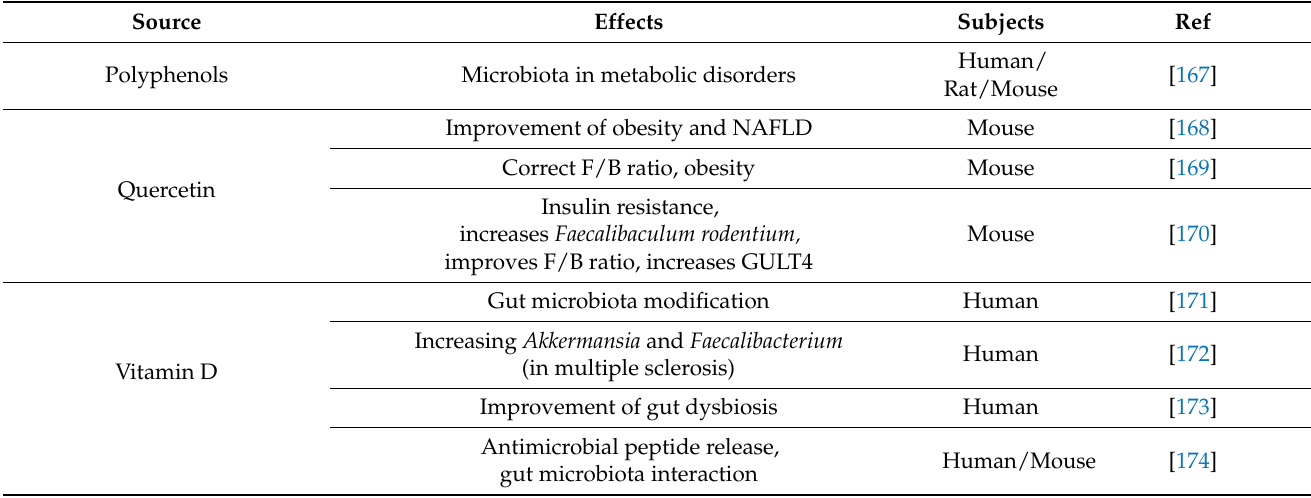
Table 4. The influence of phytochemicals and vitamin D in gut